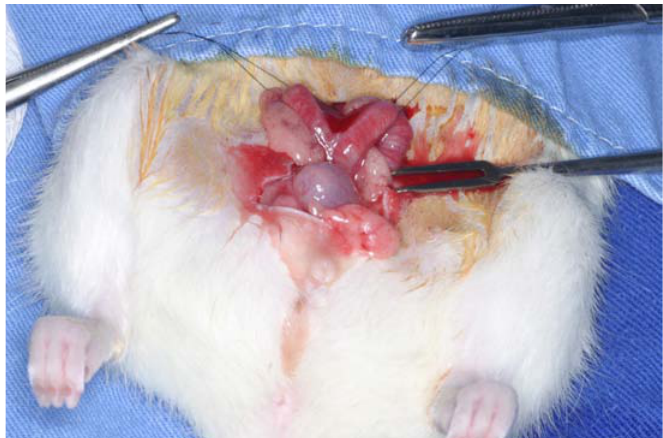
FIGURE 1 - Intraoperative photography of uterine cerclage at day 18 of gestation